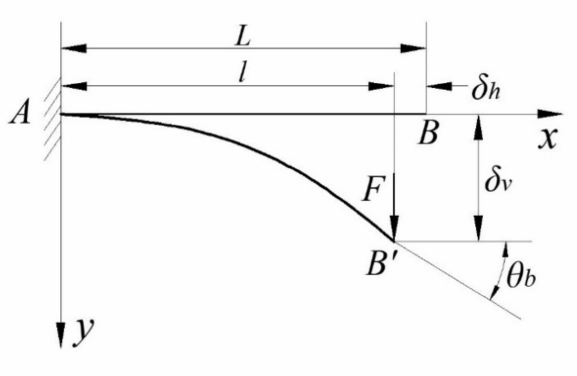
Figure 1. Large deformation of beam under point load at the free